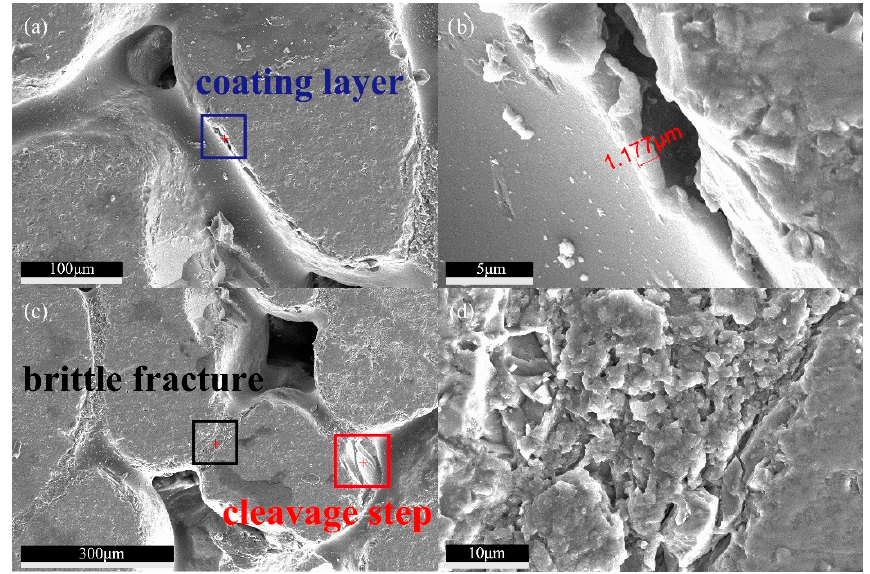
Figure 17. Characteristics of RBPB’s binder material. ( a ) Coating layer. ( b ) Thickness of coating layer. ( c ) Brittle fracture and cleavage step. ( d ) Brittle fracture details.